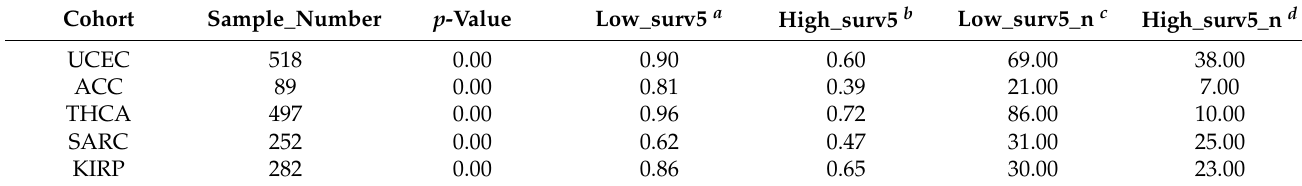
Table A2. Association between S-CIN and overall survival across cancer